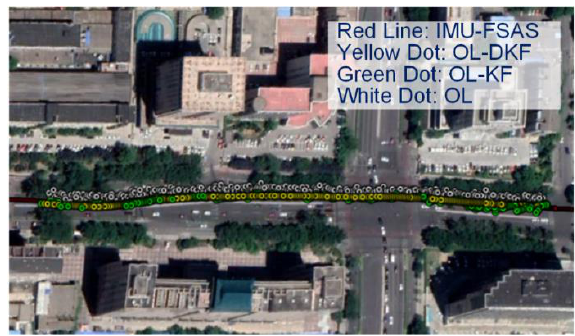
Figure 15. Satellite visibility of the unblocked road test.